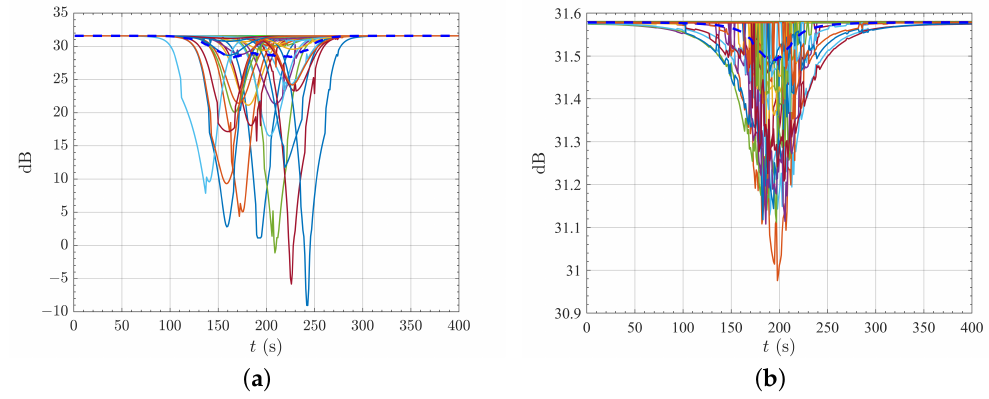
Figure 13. SNR and SINR of different GSO ground stations in different beams for the 37-beam scenario without and with channel allocation. ( a ) SNR and SINR of different GSO ground stations in different beams for the 37-beam scenario without channel allocation; ( b ) SNR and SINR of different GSO ground stations in different beams for the 37-beam scenario with channel